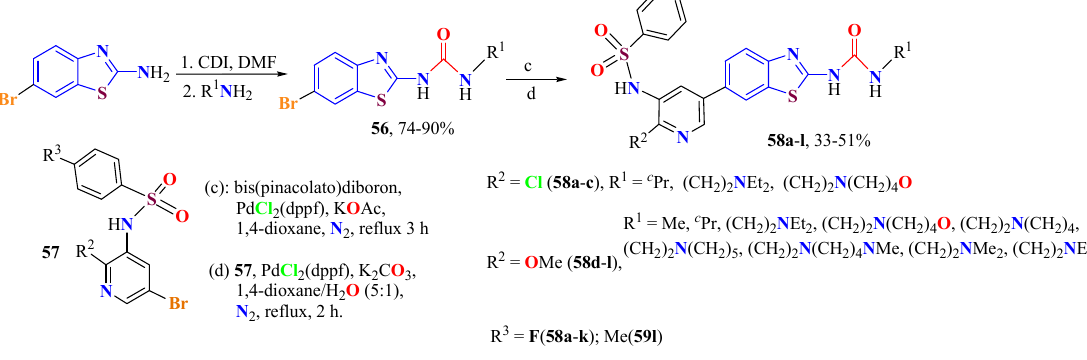
Scheme 19. The 6-bromo ethyl-substituted-UBTs 56 from 6-bromo-2ABT and CDI then substituted ethylamine to be N-aryl-sulfonated.